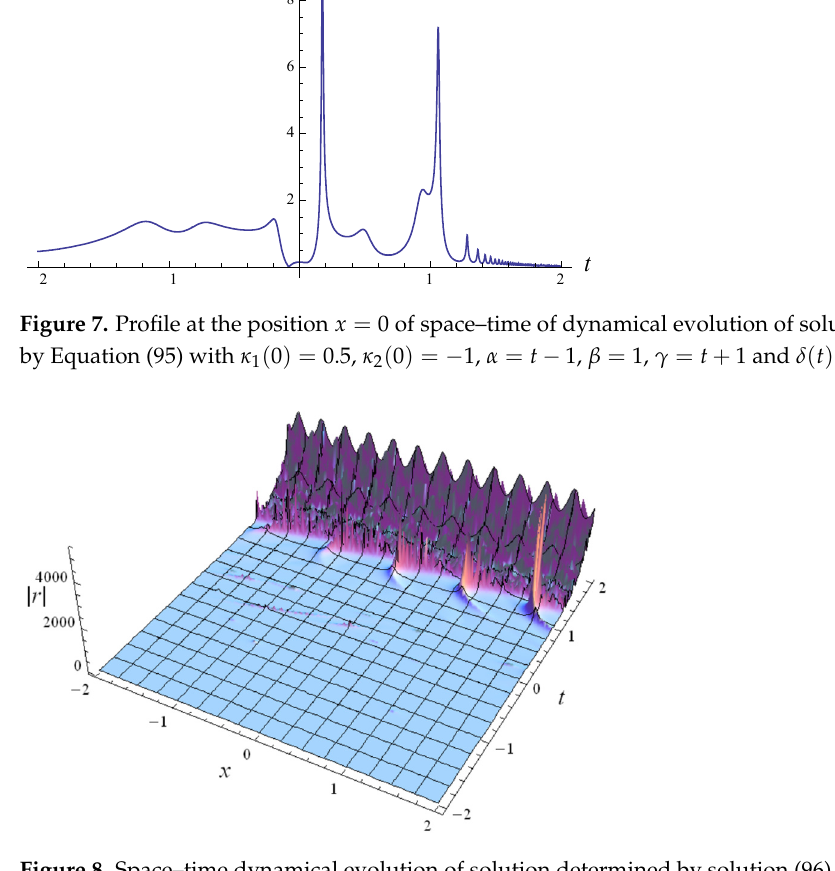
Figure 8. Space–time dynamical evolution of solution determined by solution (96) with κ 1 ( 0 ) = 0.5, κ 2 ( 0 ) = − 1, α = t − 1, β = 1, γ = t + 1 and δ ( t ) = i .